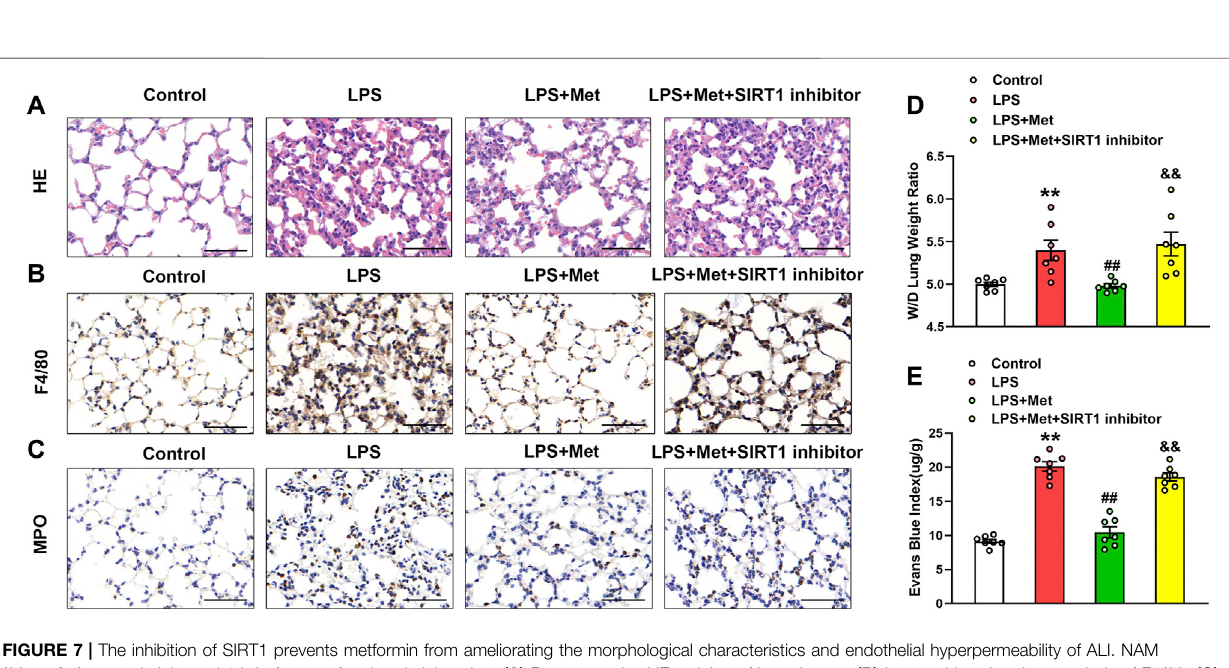
FIGURE 6 | The inhibition of SIRT1 prevents metformin from suppressing pyroptosis and vascular adhesion molecules in the lungs of LPS-induced ALI mice. (A) Represented pyroptosis-associated proteins in lung tissues of LPS-induced ALI mice after administration of NAM. (B) IL-1 β protein level was detected. (C) Representative protein bands ofICAM-1 and VCAM-1 inlung tissue. (D) Representative protein bands oftheNF- κ Bsignaling pathway in lung tissues after pretreatment withNAM. (E) LungtissueswerestainedwithNLRP3(green)andCD31(red).Nucleiwerecounterstainedwith4 ’ 6-diamidino-2-phenylindole(DAPI)(blue). (F) Lung tissues were stained with caspase-1 (green) and CD31 (red). Nuclei were counterstained with DAPI (blue). (G) Percentage of CD31 + NLRP3 + cells. (H) Percentage of CD31 + Caspase-1 + cells.Originalmagni fi cation,×200.Scalebar,50 μ m.Dataarepresentedasthemean±SEM( n =7).** p < 0.01vs.Controlgroup,## p < 0.01vs.LPS group. && p < 0.01 vs. LPS + Met group.